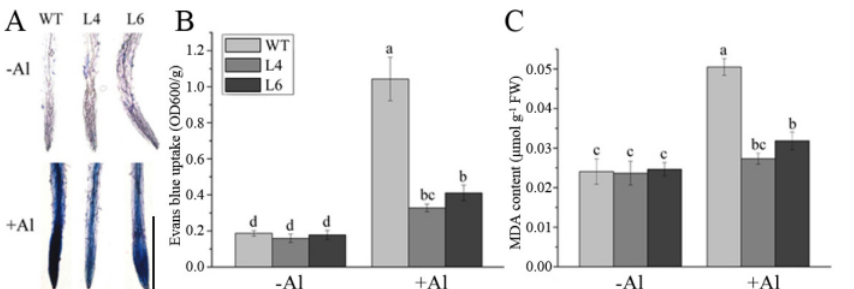
Figure 7. Effect of Al treatment on the lipid peroxidation and loss of plasma membrane integrity in roots. Seedling roots of wild–type plants and transgenic lines were collected after exposure to 60 µ M AlCl 3 for 12 h and used to evaluate ( A ) Evans blue staining, scale bar: 200 µ m; ( B ) Evans blue uptake, and ( C ) Malondialdehyde (MDA) contents. Values represent mean ± SD ( n = 20). Different letters indicate significant differences ( p < 0.01) (Tukey’s